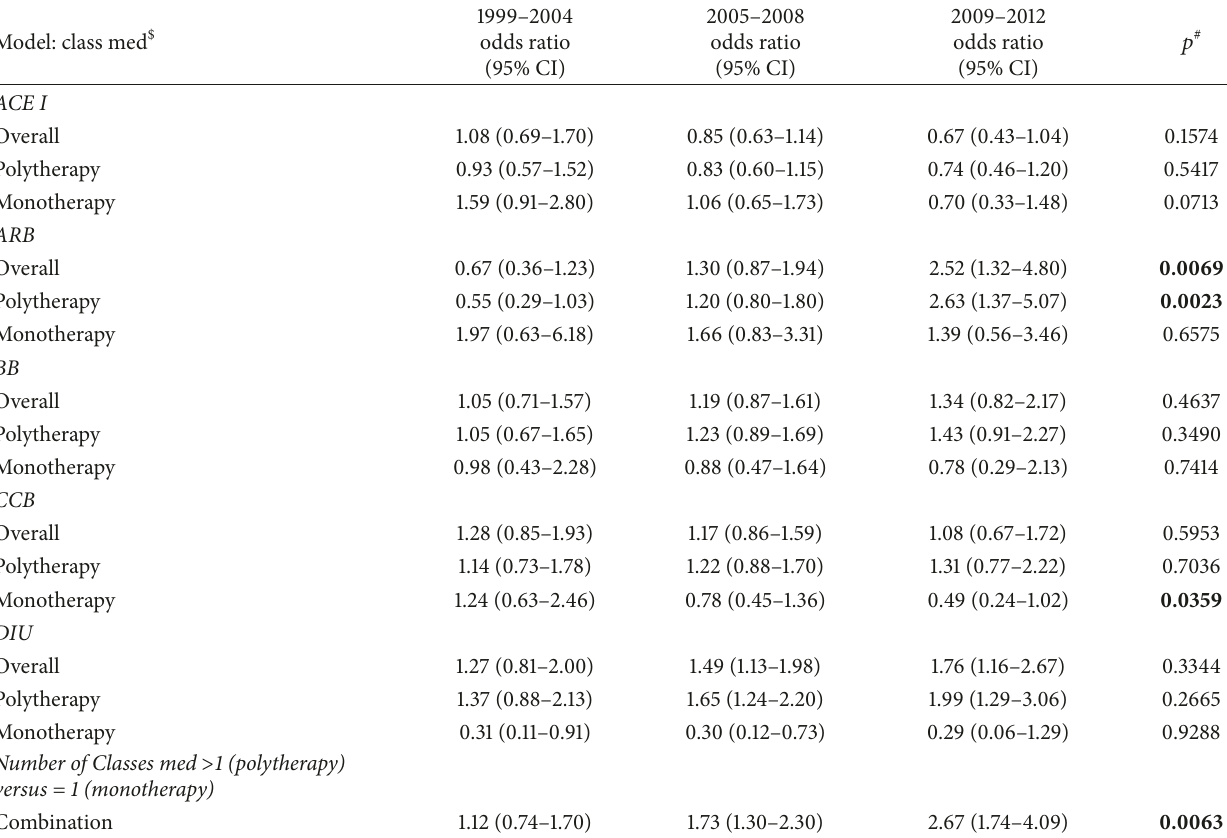
Table 2: Adjusted ## odds ratios (95% CI) for advanced (3, 4, and 5) versus early (1 and 2) stages of CKD by use of each class of